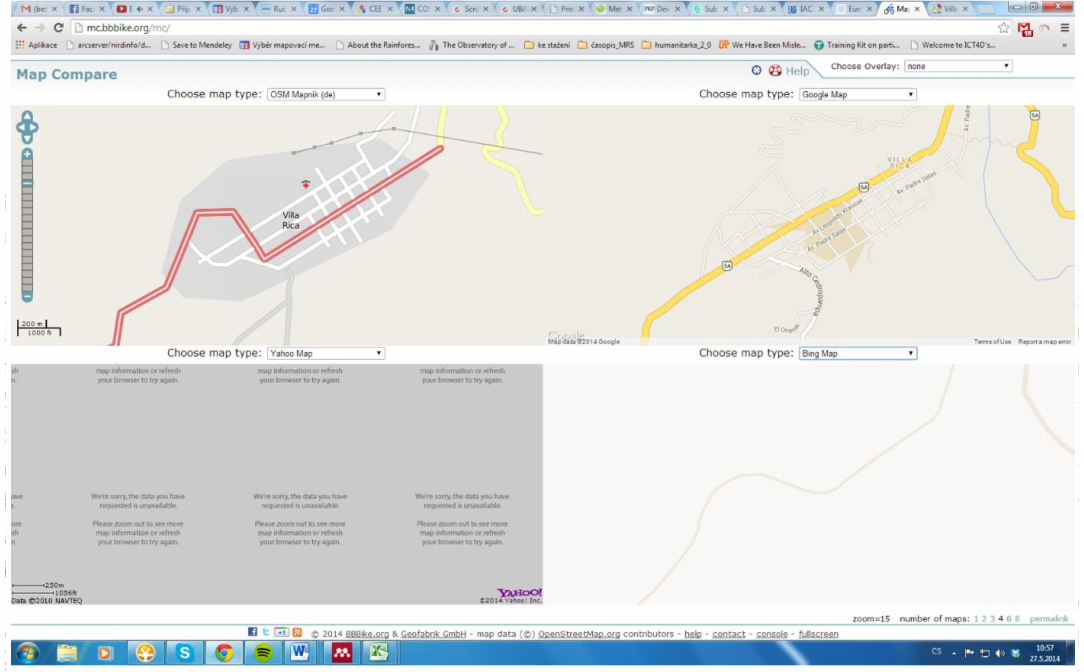
Figure 5. Villa Rica city on 4 map services at scale 1:20,000, retrieved in April